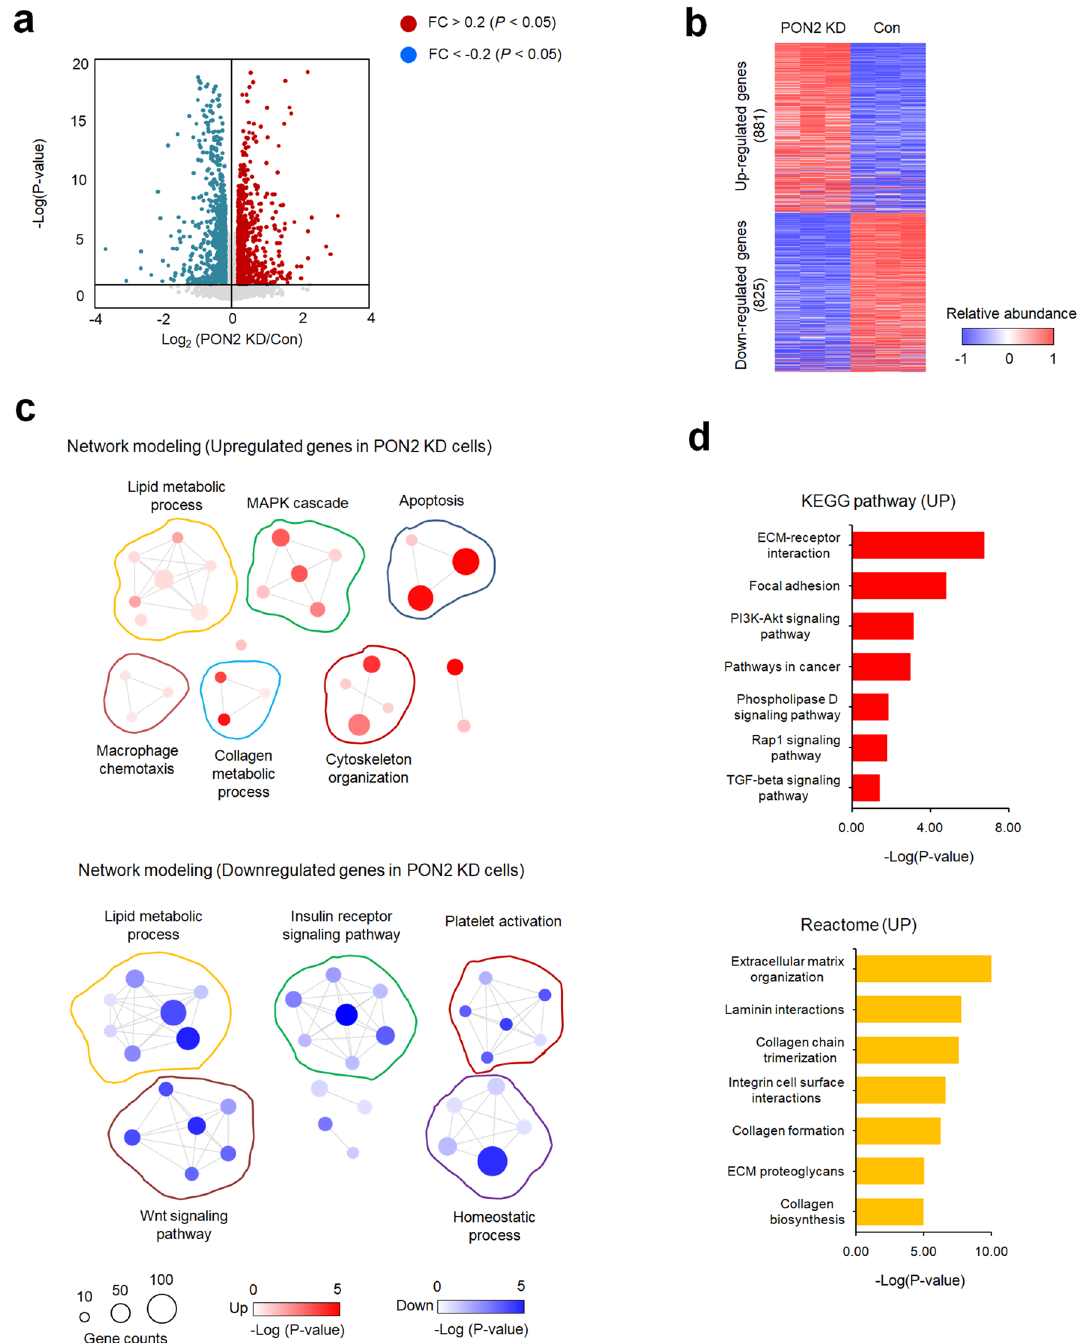
Figure 2. Transcriptome analyses using RNA-seq data in PON2-deficient and control cells. ( a ) Volcano plot of hepatic differentially expressed genes (DEGs) between the PON2 depletion and control. Genes upregulated or downregulated by more than 1.2-fold are shown in red and blue, respectively. ( b ) Two-dimensional hierarchical clustering of DEGs between different pairs of PON2-deficient and control cells. In total, 881 and 825 genes are upregulated and downregulated by PON2 depletion compared to that in control, respectively. ( c ) Network modeling scheme showing the most significant Gene Ontology (GO) biological processes for each cluster of genes upregulated (upper panel) and downregulated (bottom panel) in PON2-deficient cells relative to that in the control cells. Red and blue denote highly and weakly expressed genes, respectively, and circle size indicates gene counters. The legends for color-coding and gene counting are shown below. ( d ) Top-ranked pathways that are significantly altered in PON2-deficient cells relative to those in control cells. Upper panel represent the KEGG pathways enriched by genes exhibiting upregulated expression in PON2-deficient cells relative to those in control cells. Bottom panel represent the Reactome pathways enriched by the genes exhibiting upregulated expression in PON2-deficient cells relative to those in control cells. Each cell is color-coded based on the fold change in the expression of genes in PON2-deficient cells, relative to control